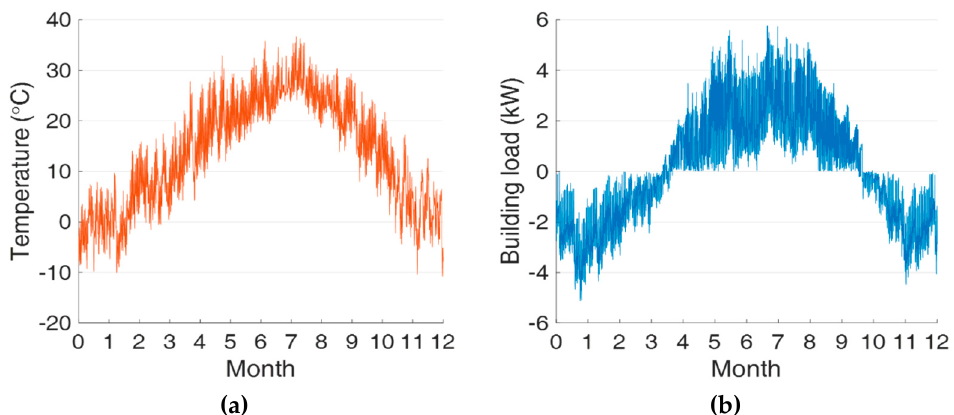
Figure 7. Annual profile of the inlet groundwater temperatures of the flow to the PDHX container.